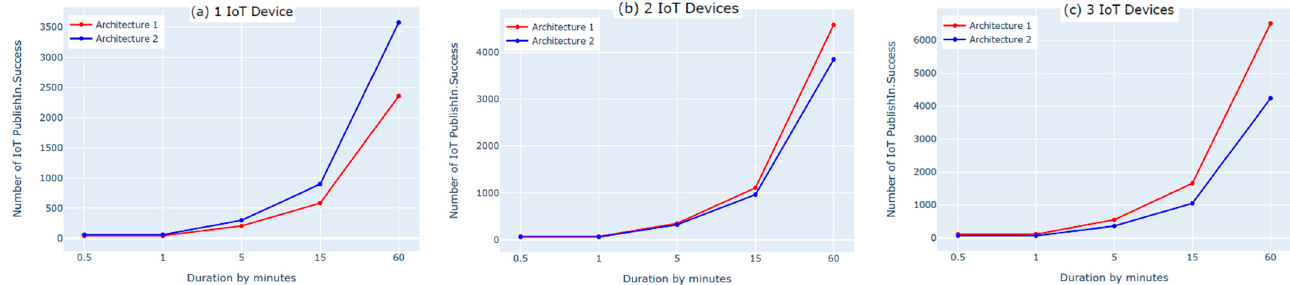
Figure 6. AWS IoT message broker PublishIn Success metrics with 1, 2, and 3 IoT devices on the North Virginia datacenter (cloud layer).